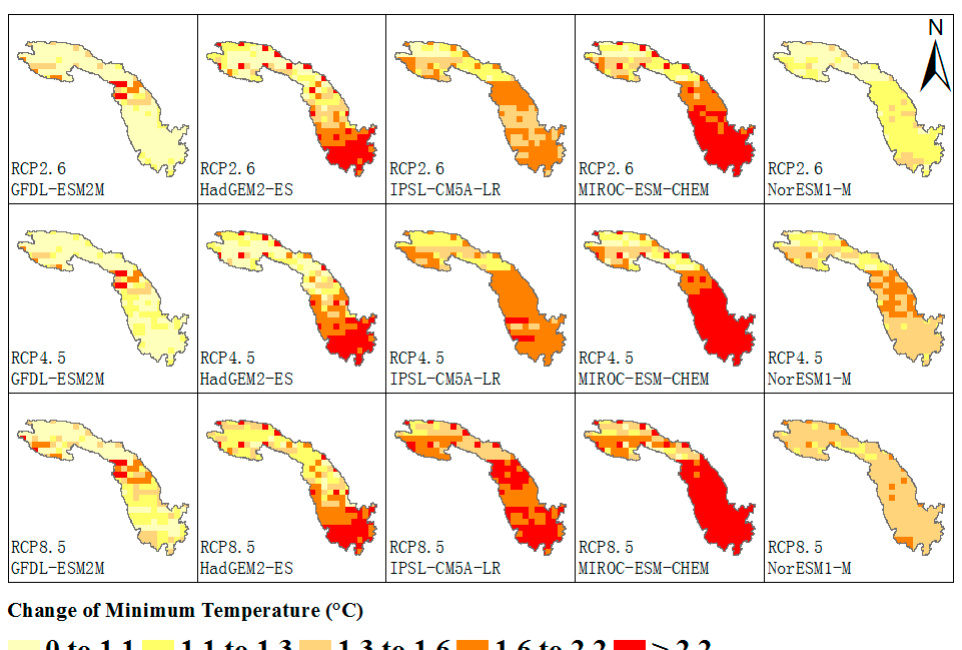
Figure 10. Change of maximum temperature.